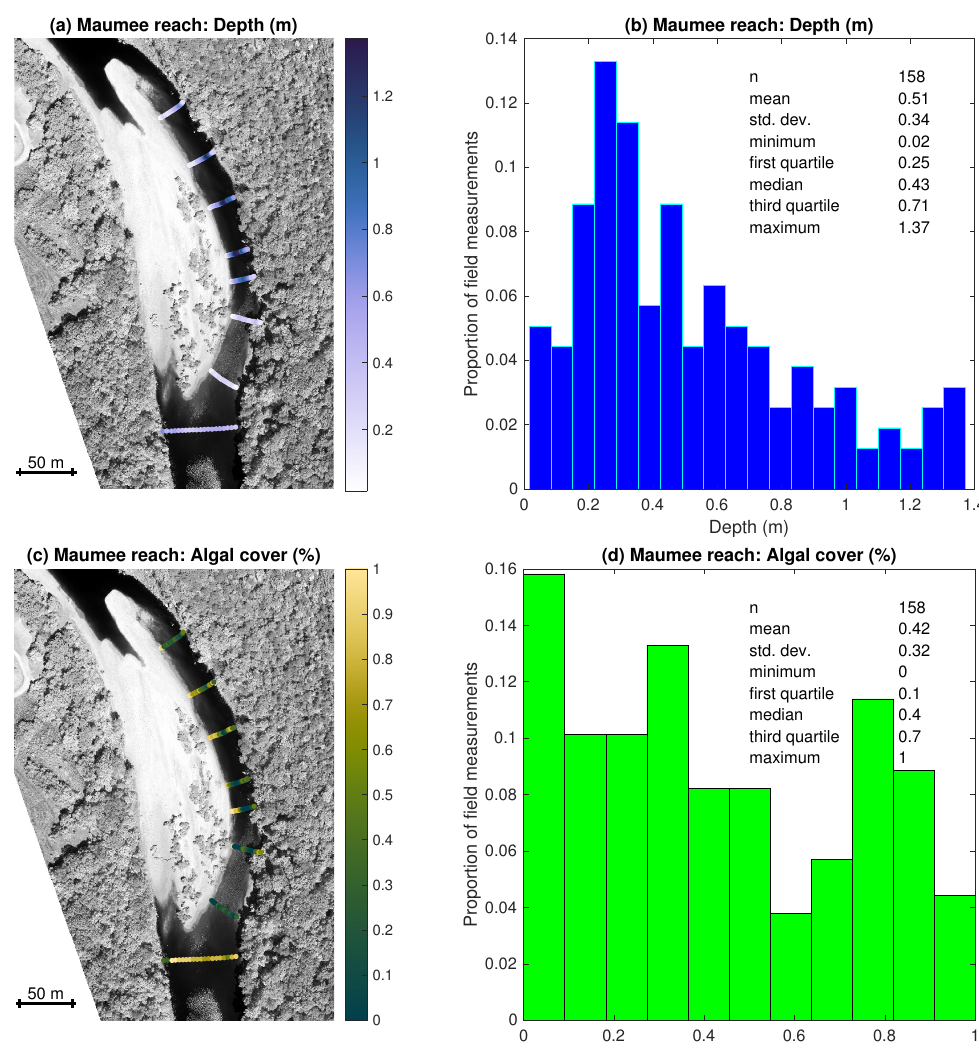
Figure 6. Field observations from the Maumee reach of the Buffalo River. Measurements of water depth are summarized in a ( a ) map and ( b ) histogram. Similarly, the data on percent cover of benthic algae are presented in ( c , d ). The background image is an orthophoto produced from the airborne data collected one day before the field measurements. Flow direction is from the bottom toward the top of the